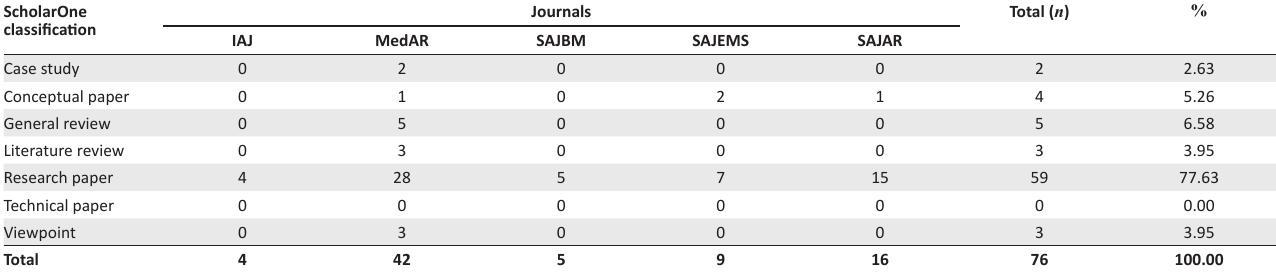
TABLE 4: Article classifications of accounting articles 2015–2016. ScholarOne classification